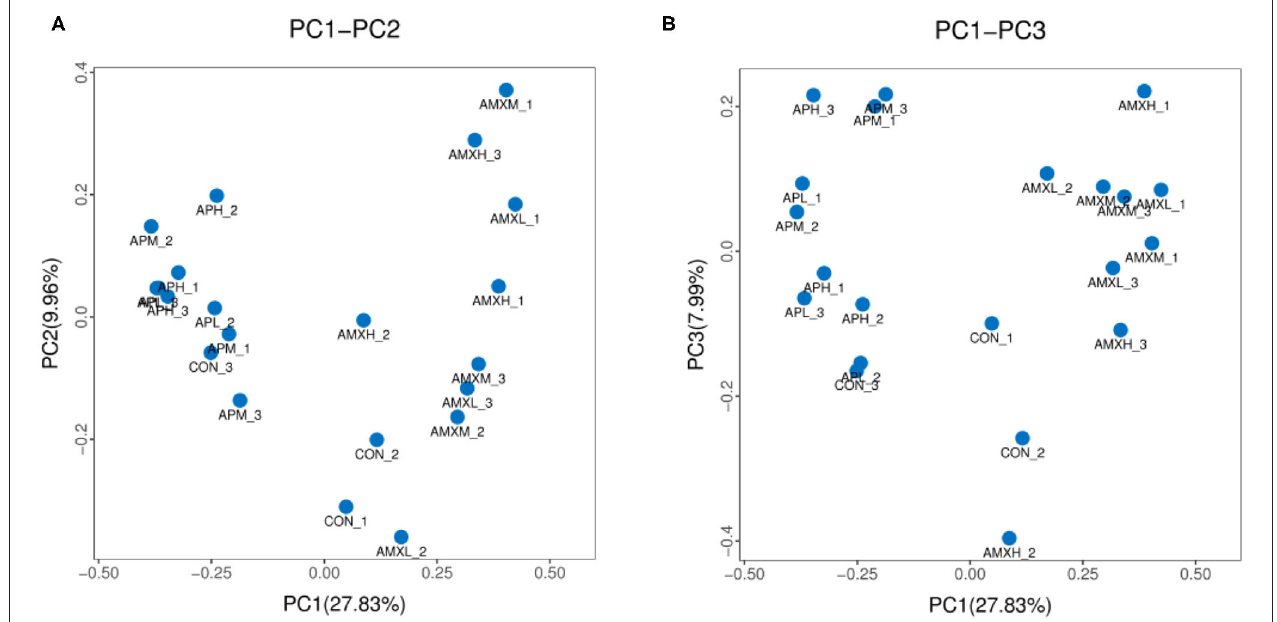
FIGURE 3 | PCoA analysis of intestinal microbial community in different groups. (A,B) represent PCoA map on the basis of unweighted and weighted uniFrac distance, respectively.